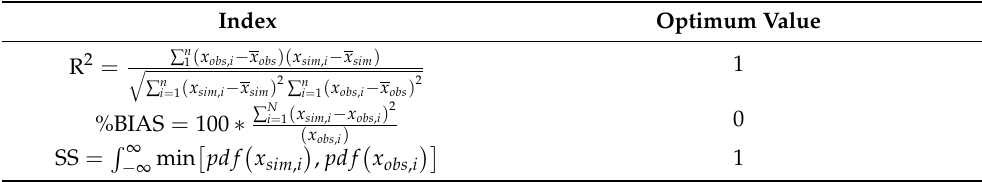
Table 4. Statistical metrics for assessing the performance of satellite-based precipitation data.